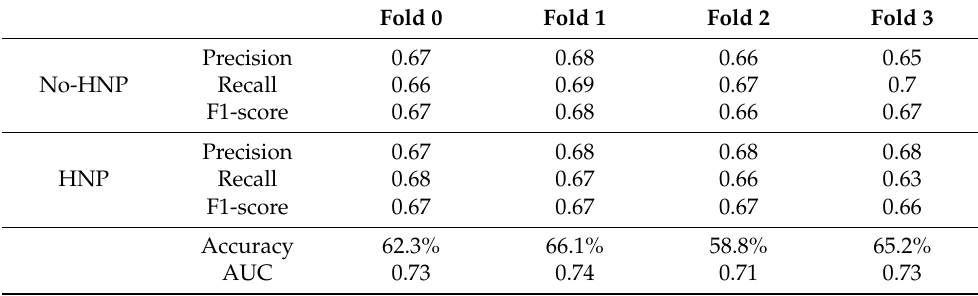
Table 2. Precision, recall, f-1 score, accuracy, and ROC AUC for HNP presence prediction.